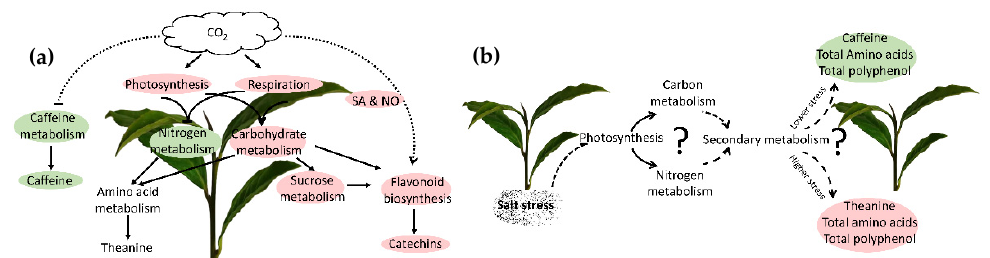
Figure 4. Metabolic changes of tea plants under elevated levels of CO 2 ( a ) and salt stress ( b ). Pink indicates up-regulated metabolic activity or increased quality components, while green indicates the down-regulation of metabolic activity or a decrease in quality components.